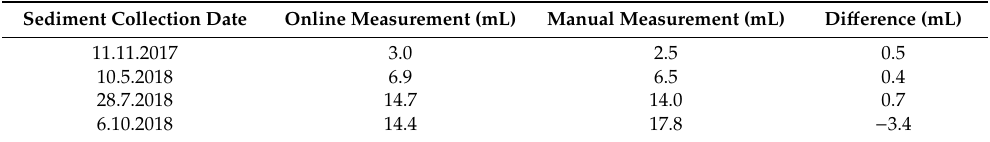
Table 1. Sediment collection dates and volumes.